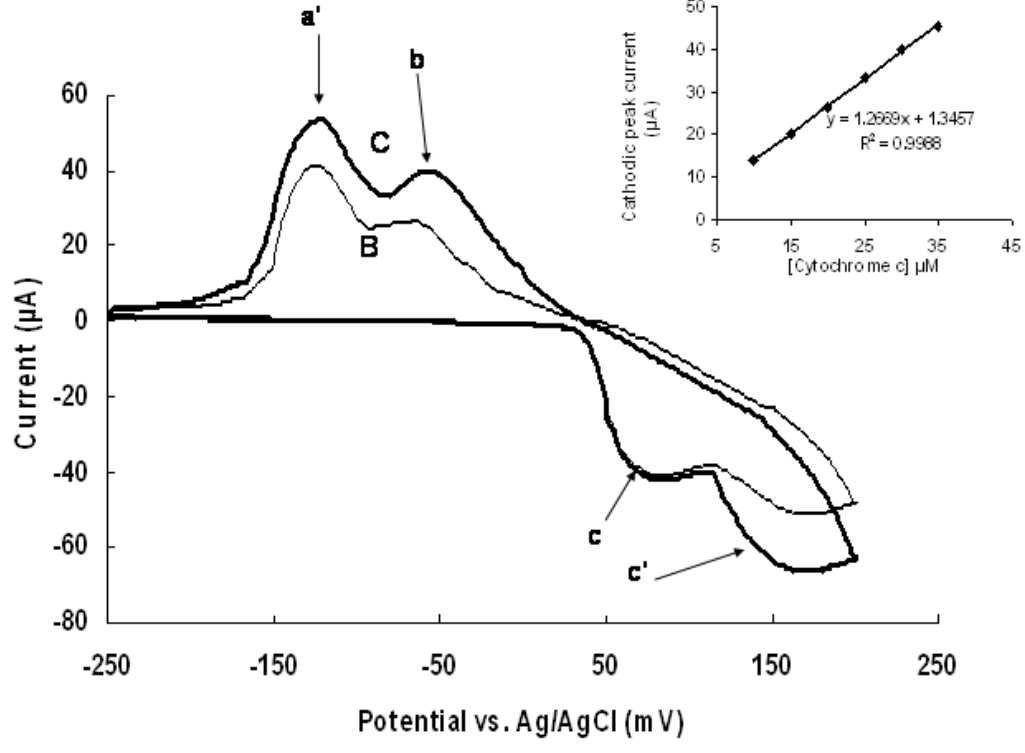
Figure 4. Cyclic voltammograms of silver electrode in a solution of 0.1 M KNO bromide ions and 20 µM cytochrome c (C) 300 µM bromide ions and 30 µM cytochrome c. In